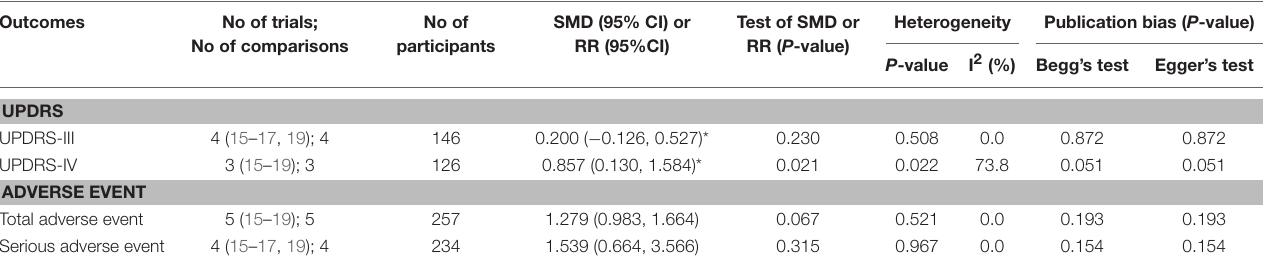
TABLE 4 | Summary of the efficacy, heterogeneity, and publication bias.